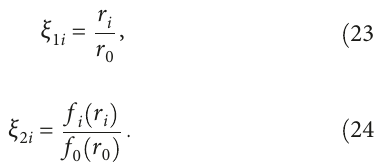
Figure 2: MIP results of dromedary soil [63].